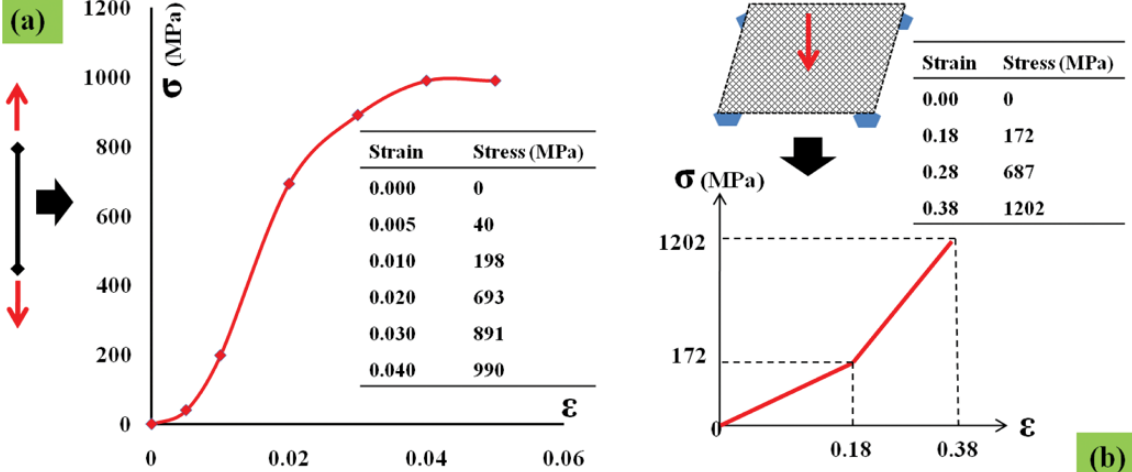
Fig. 5. Nonlinear stress-strain curves of cable (a) and shell equivalent wire-net (b) .